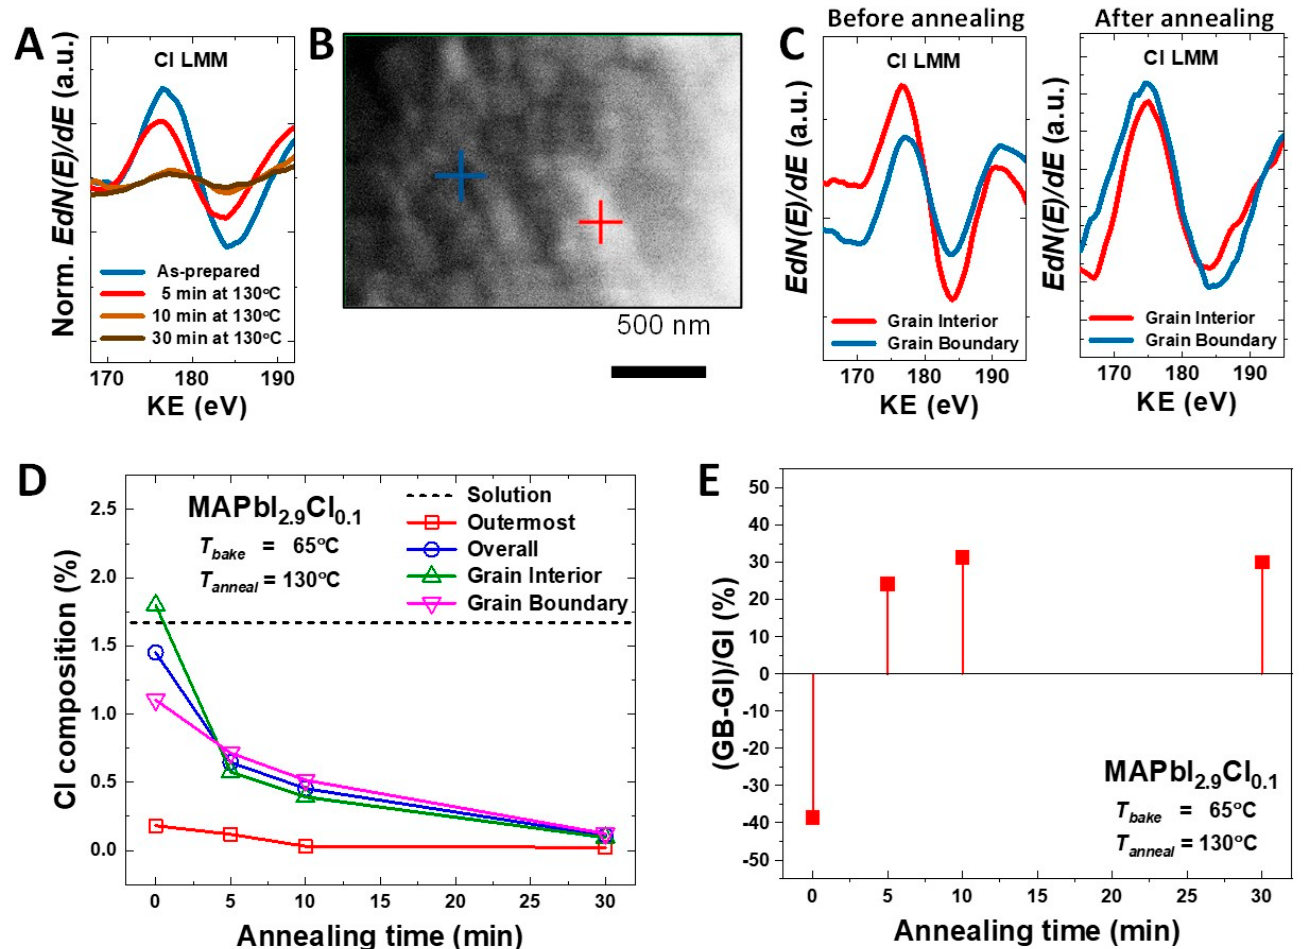
Figure 3. Nano-auger electron spectroscopy (n-AES) from MAPbI 3 − x Cl x (x = 0.10). ( A ) Auger peaks of chlorine from outermost surface during the annealing process, ( B ) in-situ SEM imaging under the n-AES mode. Cross marks point out the regions where the auger signals were collected: the blue cross is for grain boundary and the red cross is for grain interior. ( C ) Auger peaks collected from grain interior (GI) and grain boundary (GB) before/after annealing at 130 °C for 10 min, ( D ) amount of chlorine at various points as the function of annealing time, ( E ) relative amount of chlorine detected from GB and GI ((GB − GI)/GI × 100%).